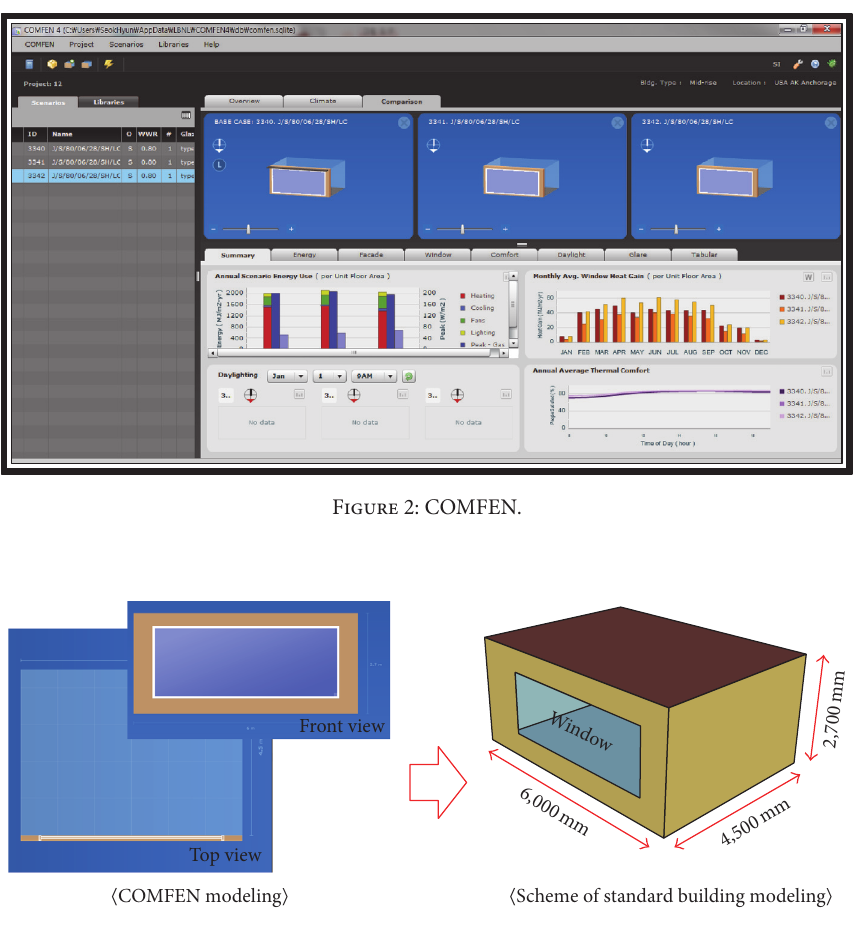
Figure 3: Energy simulation modeling by various WWR and orientation (BASE case).